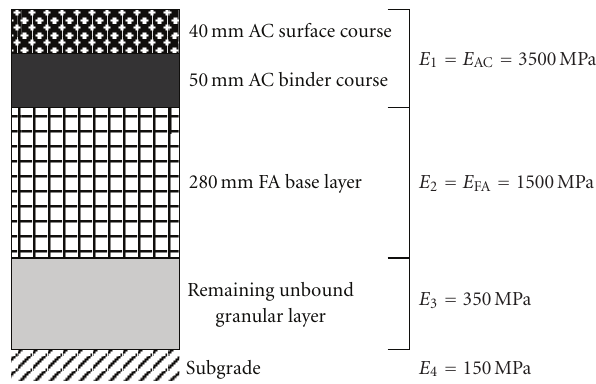
Figure 4: Pavement design cross-section of the in-depth recycled